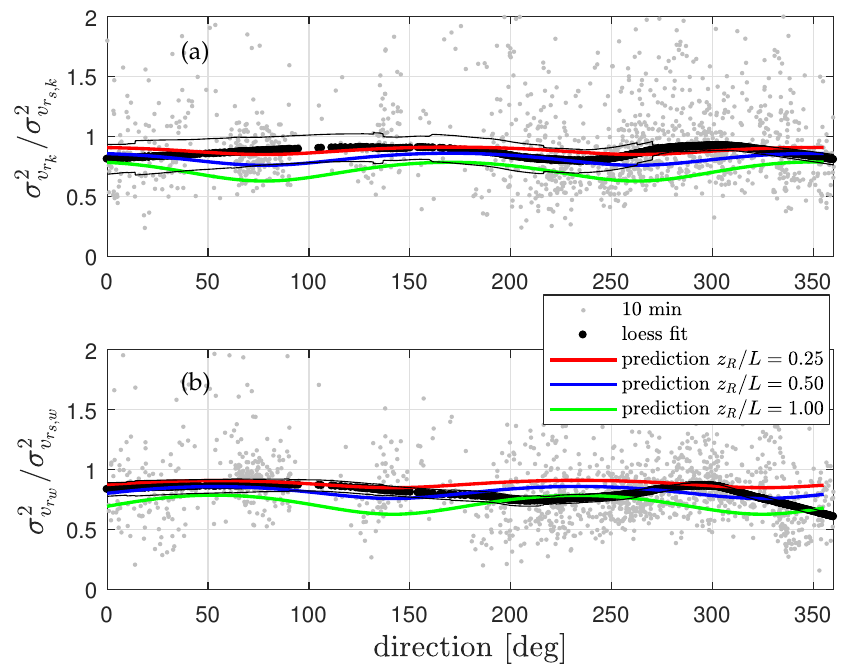
Figure 8. Ratio of the radial velocity variance of the WindScanners to the sonic anemometer as a function of wind direction in the beam direction of the k lidar ( a ) and w lidar ( b ). Measurements and a loess fit to the measurements are shown in markers and predictions in colored solid lines. The standard error of the loess fit is shown in solid black